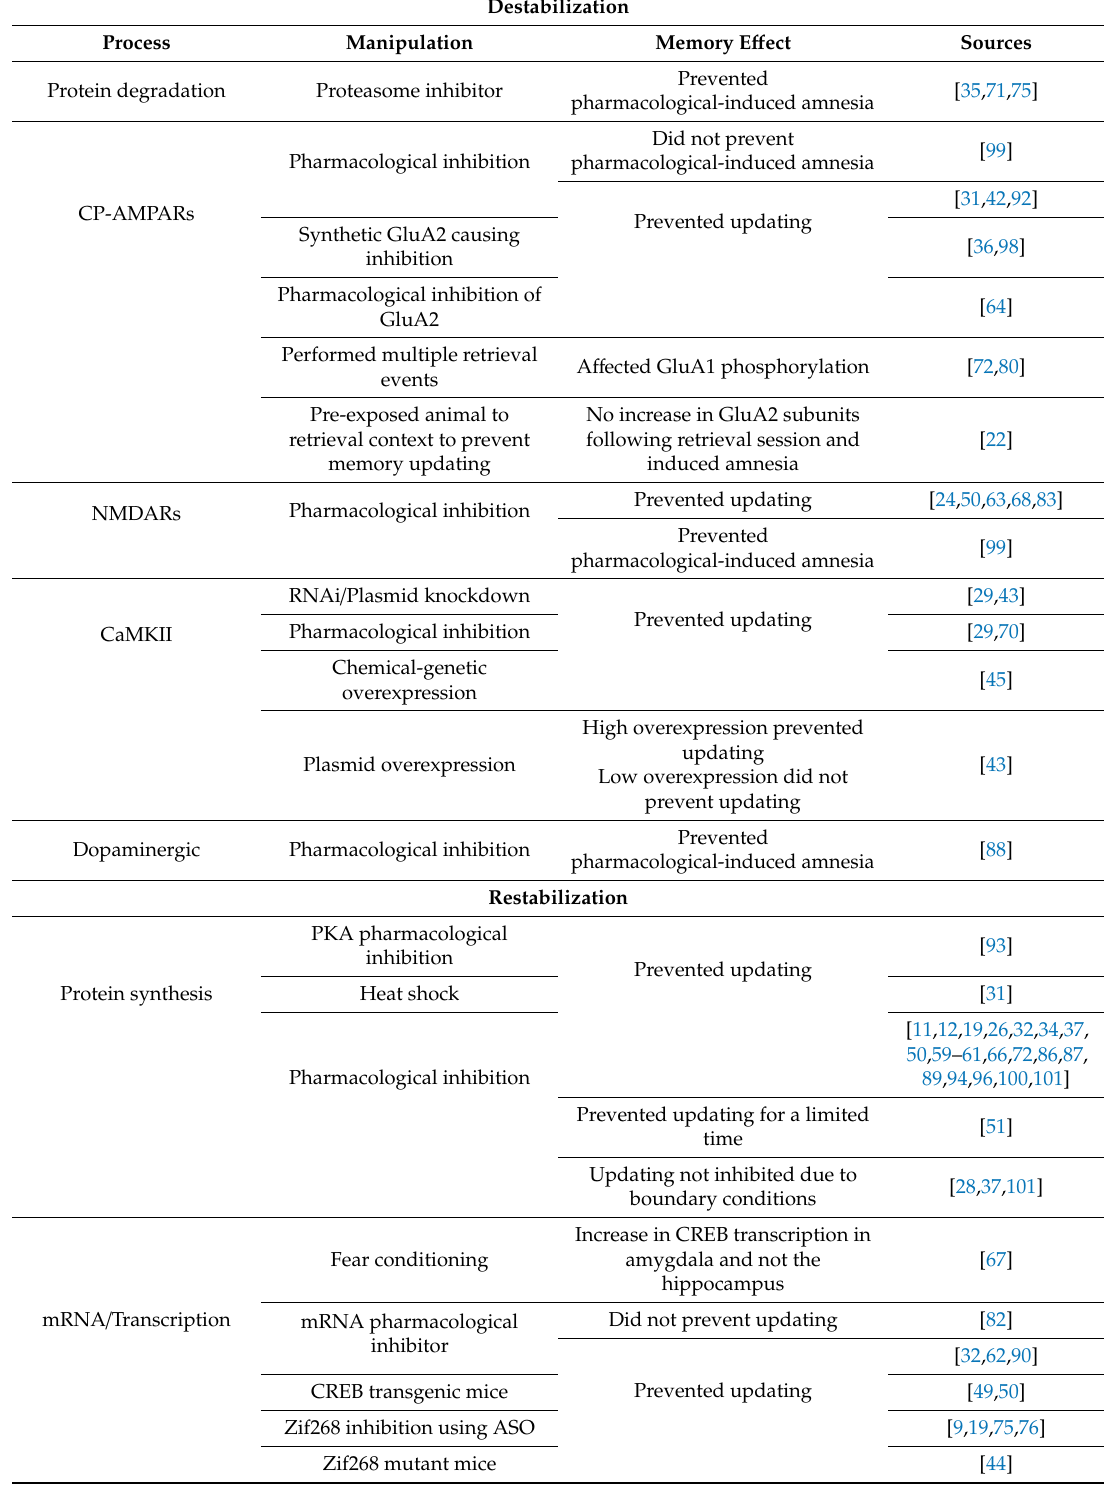
Table 2. Molecular mechanisms required for the destabilization and restabilization phases of reconsolidation-dependent memory